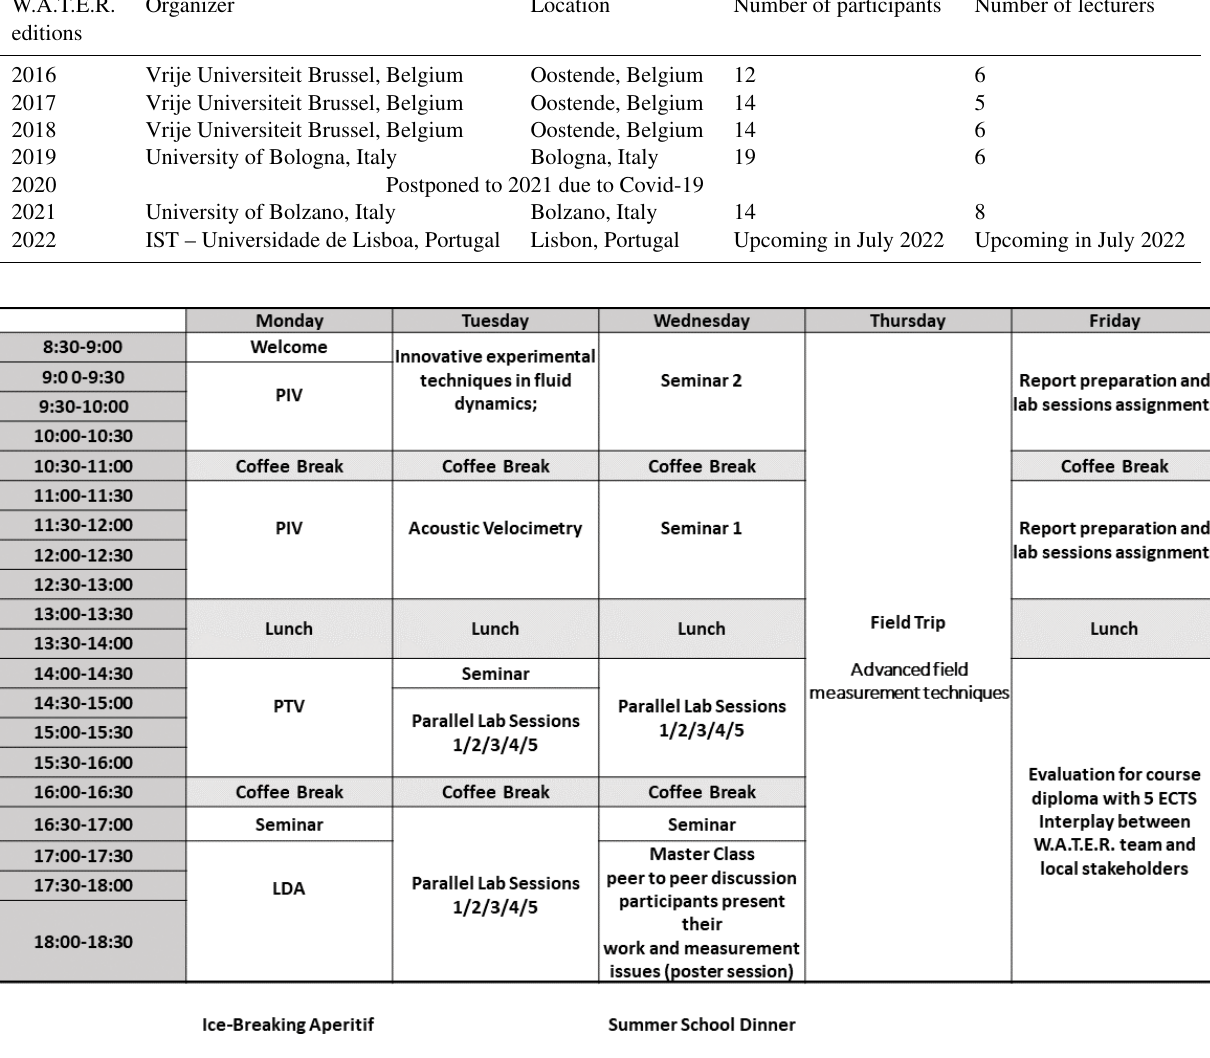
2022): this allows easier communication and interaction with potential